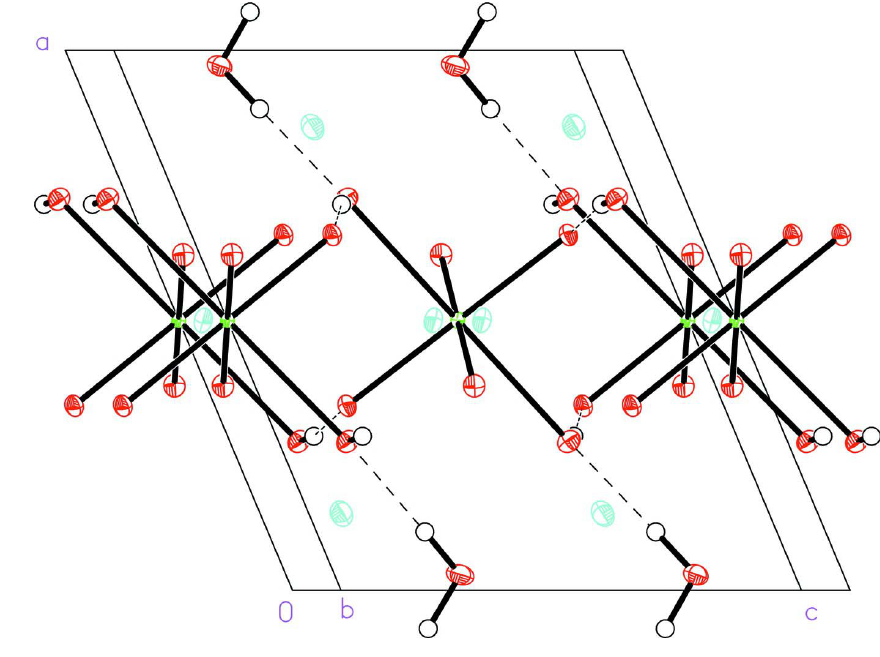
The unit cell of